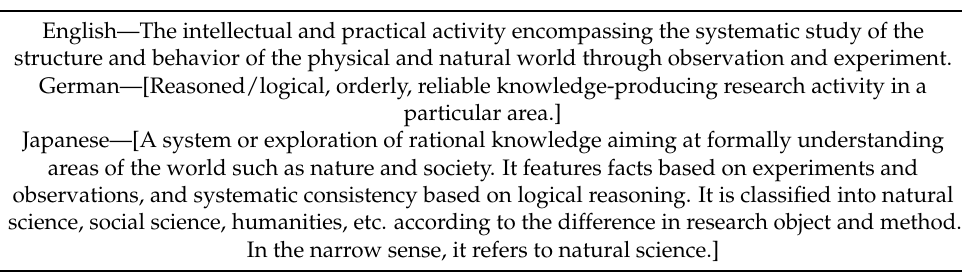
Table 2. Sociology, a science by definition. English—The science of society, social institutions, and social relationships; specifically: the systematic study of the development, structure, interaction, and collective behavior of organized groups of human beings. German—[Science; study of the coexistence of humans in a community or society, of the manifestations, developments and regularities of social life.] problems, etc., in relation to human social behavior.]